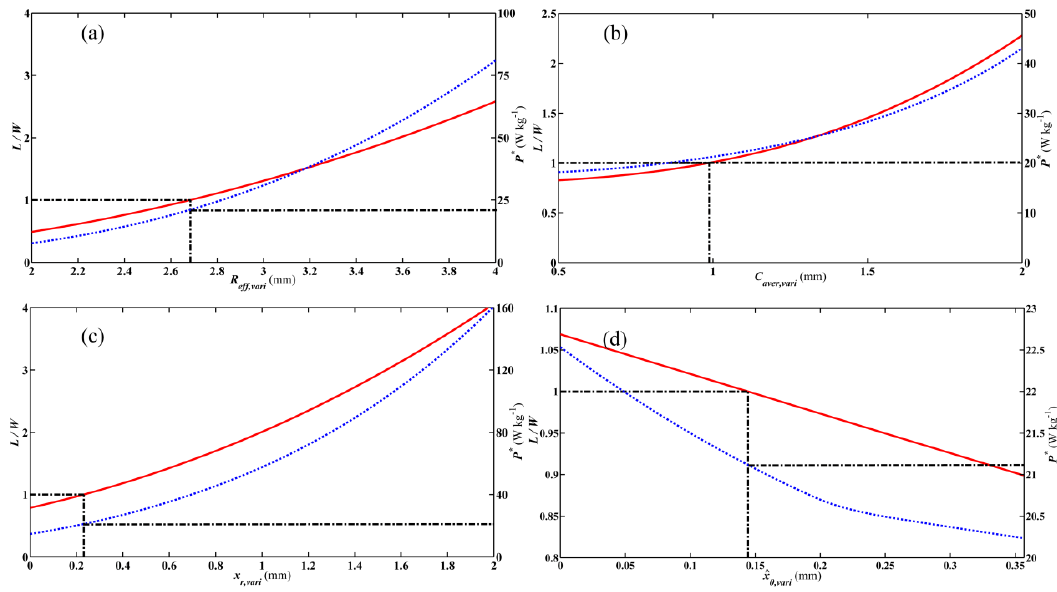
Figure 8. ( a – d ) Single ‐ parameter sensitivity analyses for optimal WGP. The ratio of lift ‐ to ‐ weight ( L / W ) and power density ( P *) as the function of some given WGP are illustrated by red solid lines and blue dashed lines in Figure 8, respectively. The black dot ‐ dash vertical lines indicate the position of optimal value for the parameter in question. The black dot ‐ dash horizontal lines denote the location where L / W = 1. The black dash horizontal lines indicate the corresponding value of power density when L / W = 1.